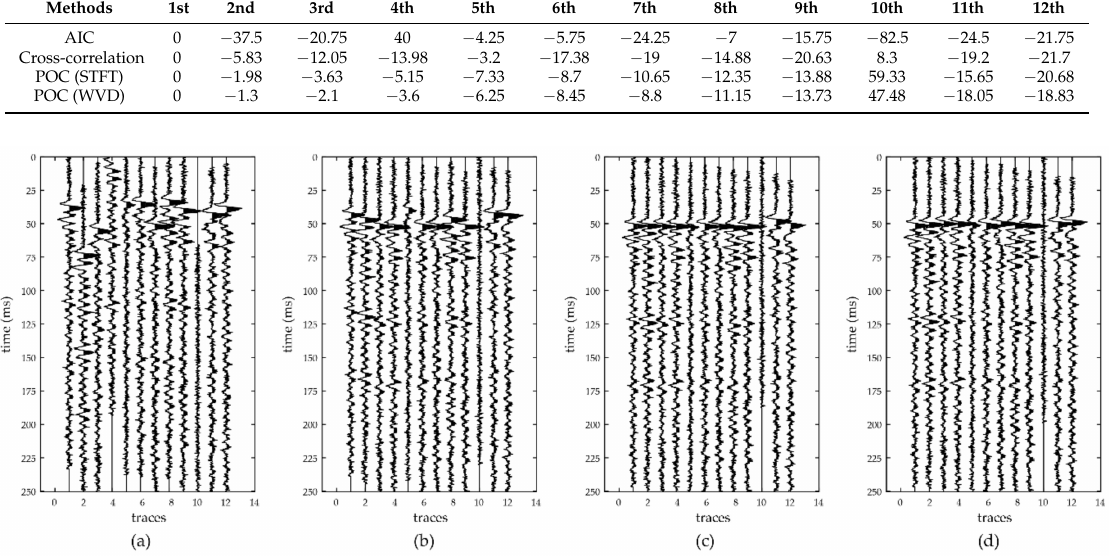
Figure 10. Using estimation values of the relative arrival times to eliminate the arrival time difference among the traces of the first noisy dataset. ( a ) The result based on AIC; ( b ) the result based on cross-correlation; ( c ) the result based on POC (STFT); ( d ) the result based on POC (WVD).